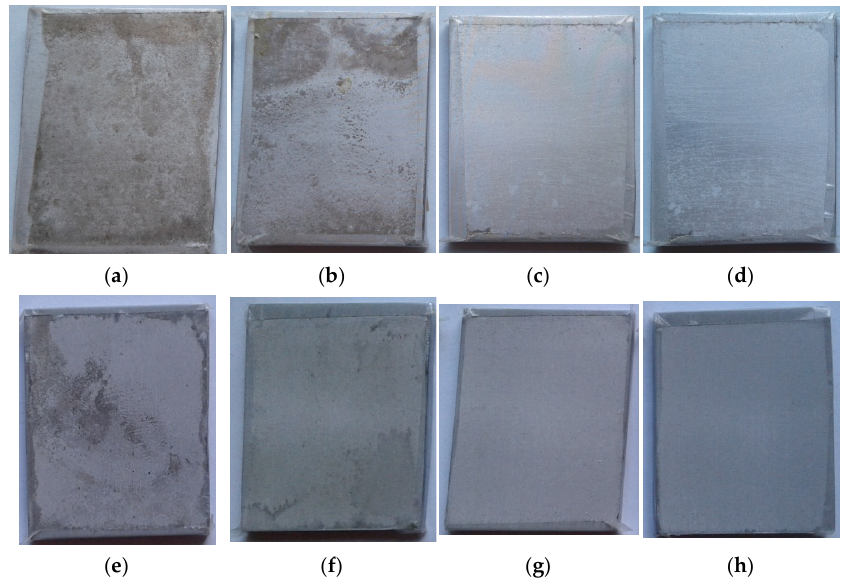
Figure 8. Images of 6060 alloy samples preliminarily subjected to LP-1 ( a – d ) and LP-2 ( e – h ) and then modified by: 10 SA ( b,f ); layer by layer 10 vs. and 10 SA ( c,g ); ODPA ( d,h ) after 35 days of testing in a salt spray chamber.